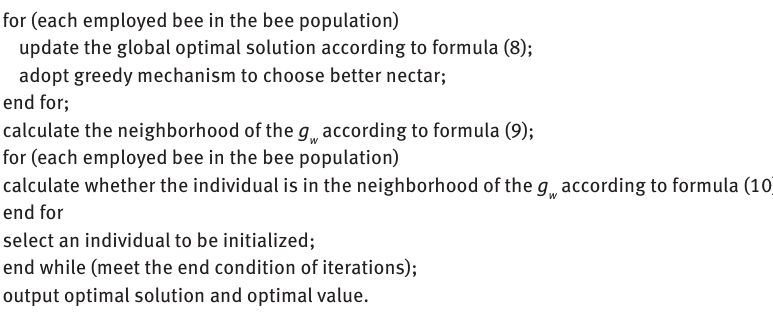
Table 1: Numerical Benchmark Functions. Function Formula Search range